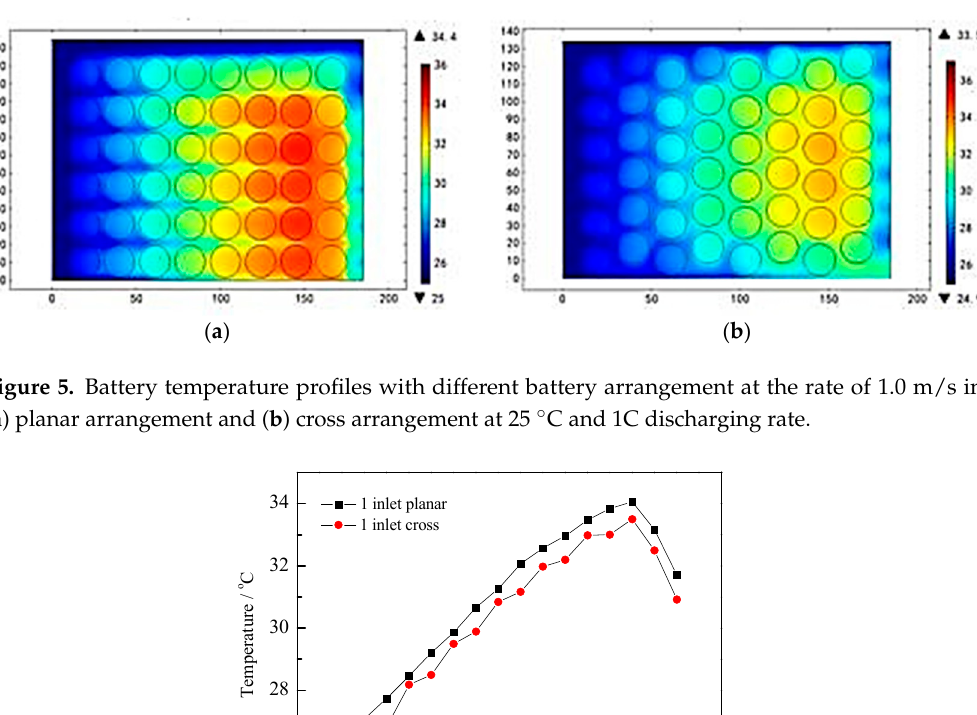
( b ) Figure 4. ( a ) A quarter of the schematic view for a cross arrangement; and ( b ) distribution of the monitoring points.